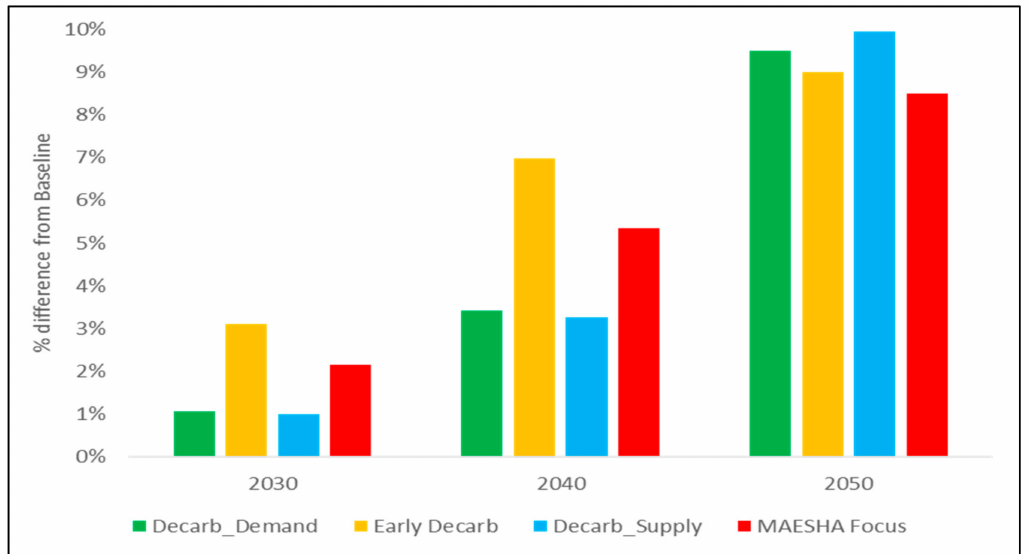
Figure 14. Impacts of decarbonization scenarios on Mayotte’s employment; source: